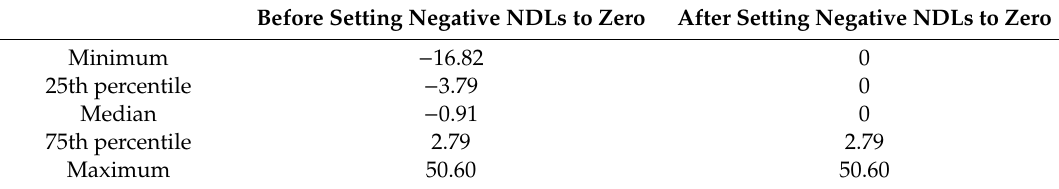
Table 2. NDL in µ g / m 3 of the Masenberg station, most suitable to act as regional background station, before and after negative values were set to zero.